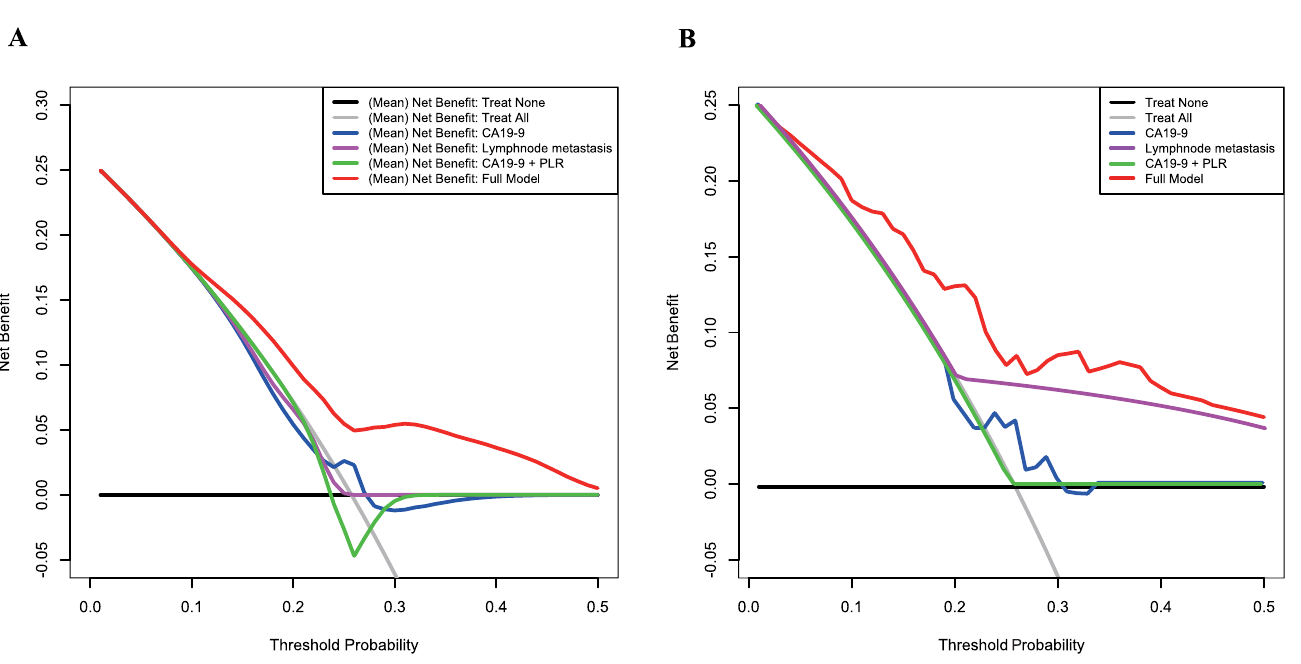
Fig 2. Decision curve analysis for the constructed models and other risk factors in (A) repeated 10-fold cross validation and (B) the entire cohort. The net benefit (y- axis) was calculated by summing the benefits (true-positive results) and subtracting the harms (false-positive results). The constructed models had the highest (mean) net benefit compared with the other